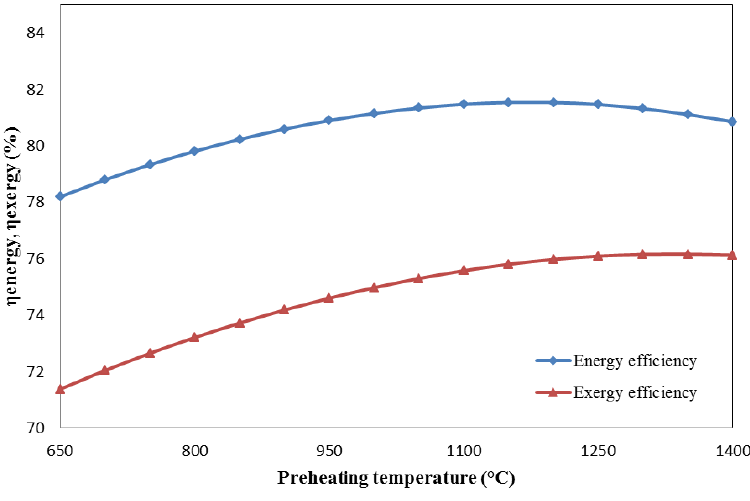
Figure 8. Energy and exergy efficiencies of the HTAG process as a function of preheating temperature for S/B =